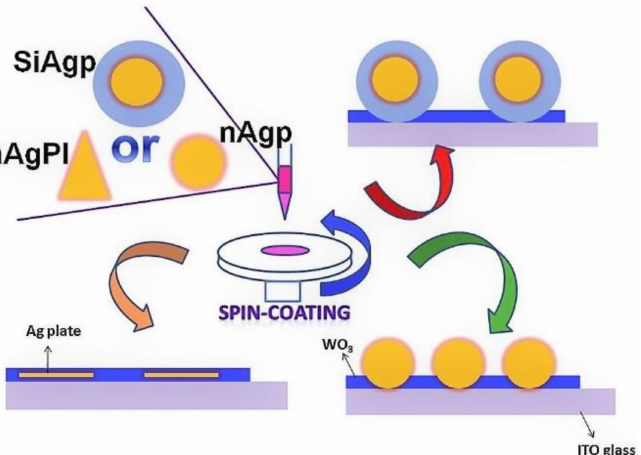
Figure 5. Schematic representation of different silver nanoparticles structures/WO 3 layers by spin coating. Adapted with permission from [141]. Copyright 2016,